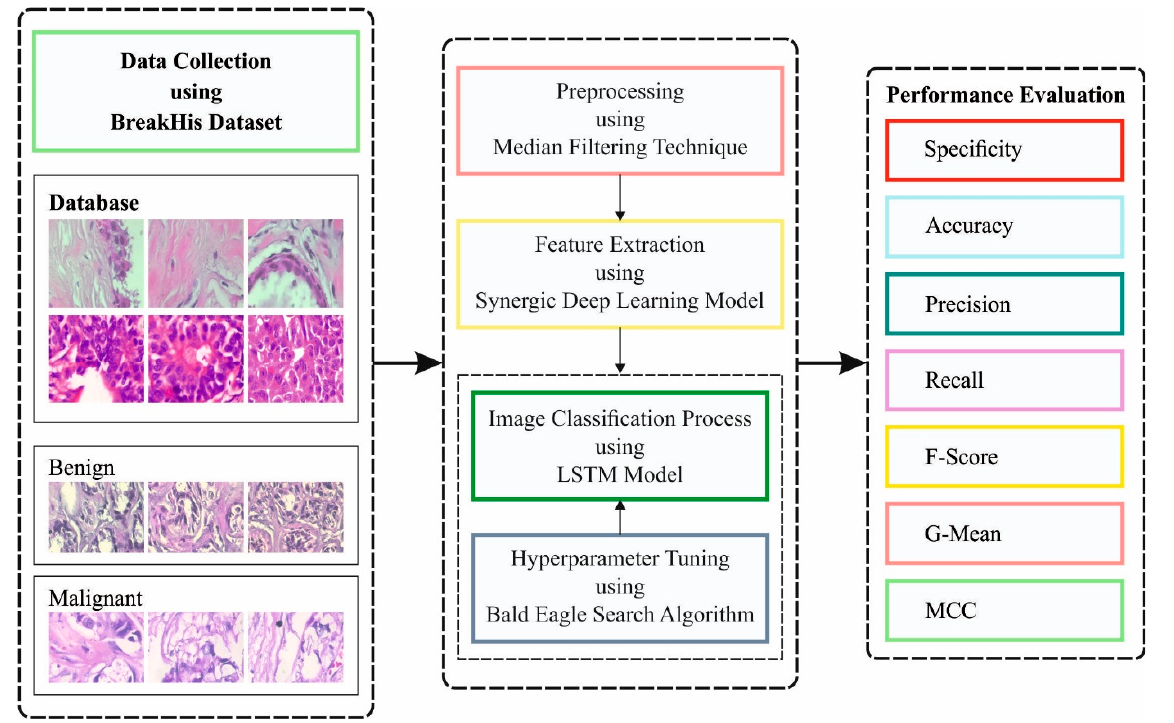
Figure 1. Workflow of the proposed IBESSDL-BCHI methodology.